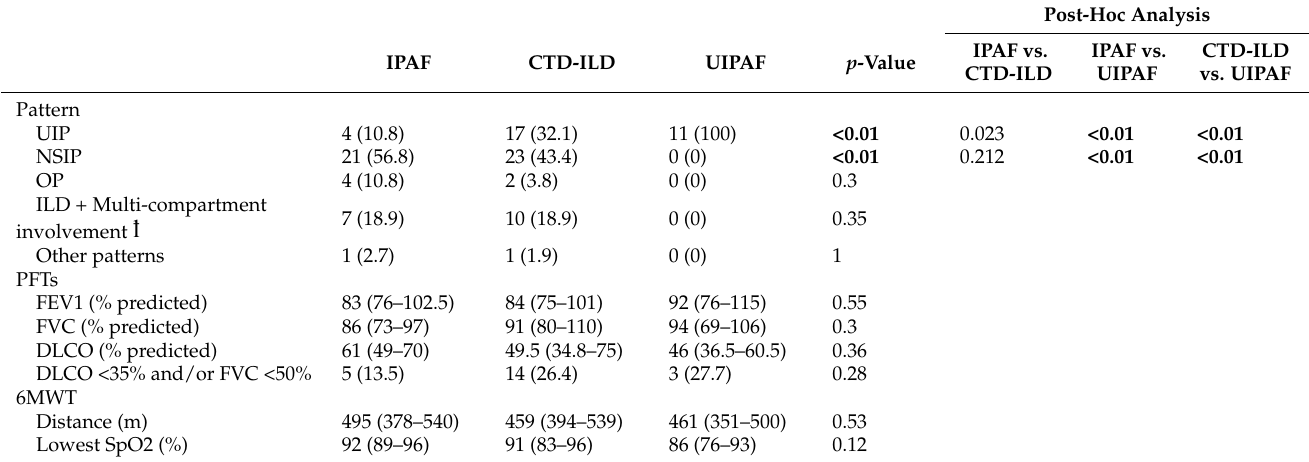
Data are presented as Odds Ratio (OR) and 95% Confidence Interval (CI). The composite endpoint of ILD progression is characterized by an absolute decline in FVC ≥5% and/or in DLCO ≥10% pre- dicted and/or deterioration on HRCT. Multivariate analysis was adjusted for sex and age and in- cluded data with a p < 0.1 on univariate analysis (bold font). ꝉ Therapy with an-fibrotic agent was excluded from multivariate analysis, given the high association with UIP pattern (phi = 0.59; p < 0.01). Legend: ARDS, acute respiratory distress syndrome; IPAF, interstitial pneumonia with auto-